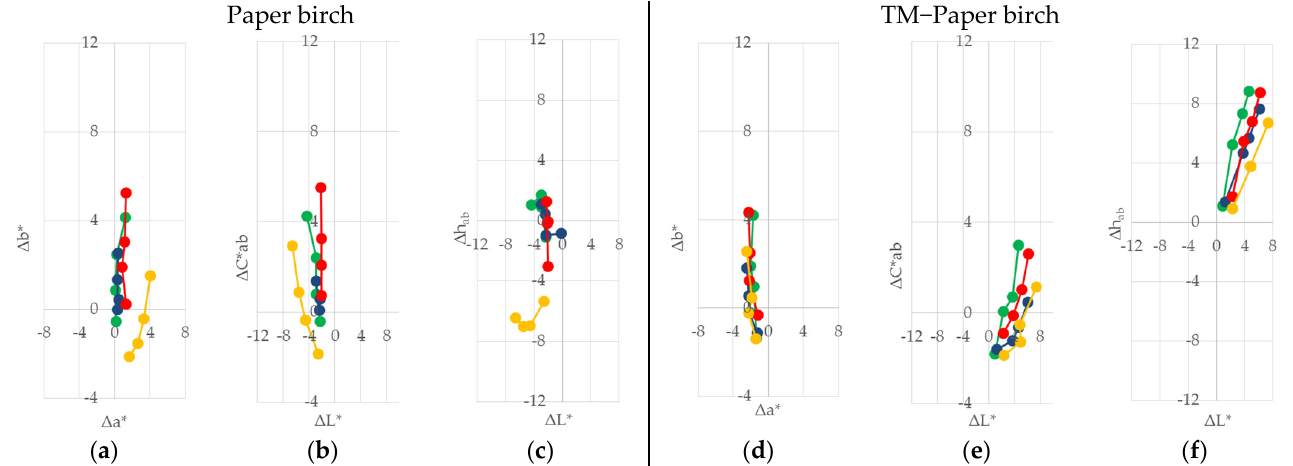
Figure 4. Changes in ∆ L* , ∆ a* , ∆ b* , ∆ C* ab , and ∆ h ab after the exposure to indoor sunlight of coated and uncoated native ( a – c ), and thermally treated ( d – f ), Paper birch wood for 60 days.